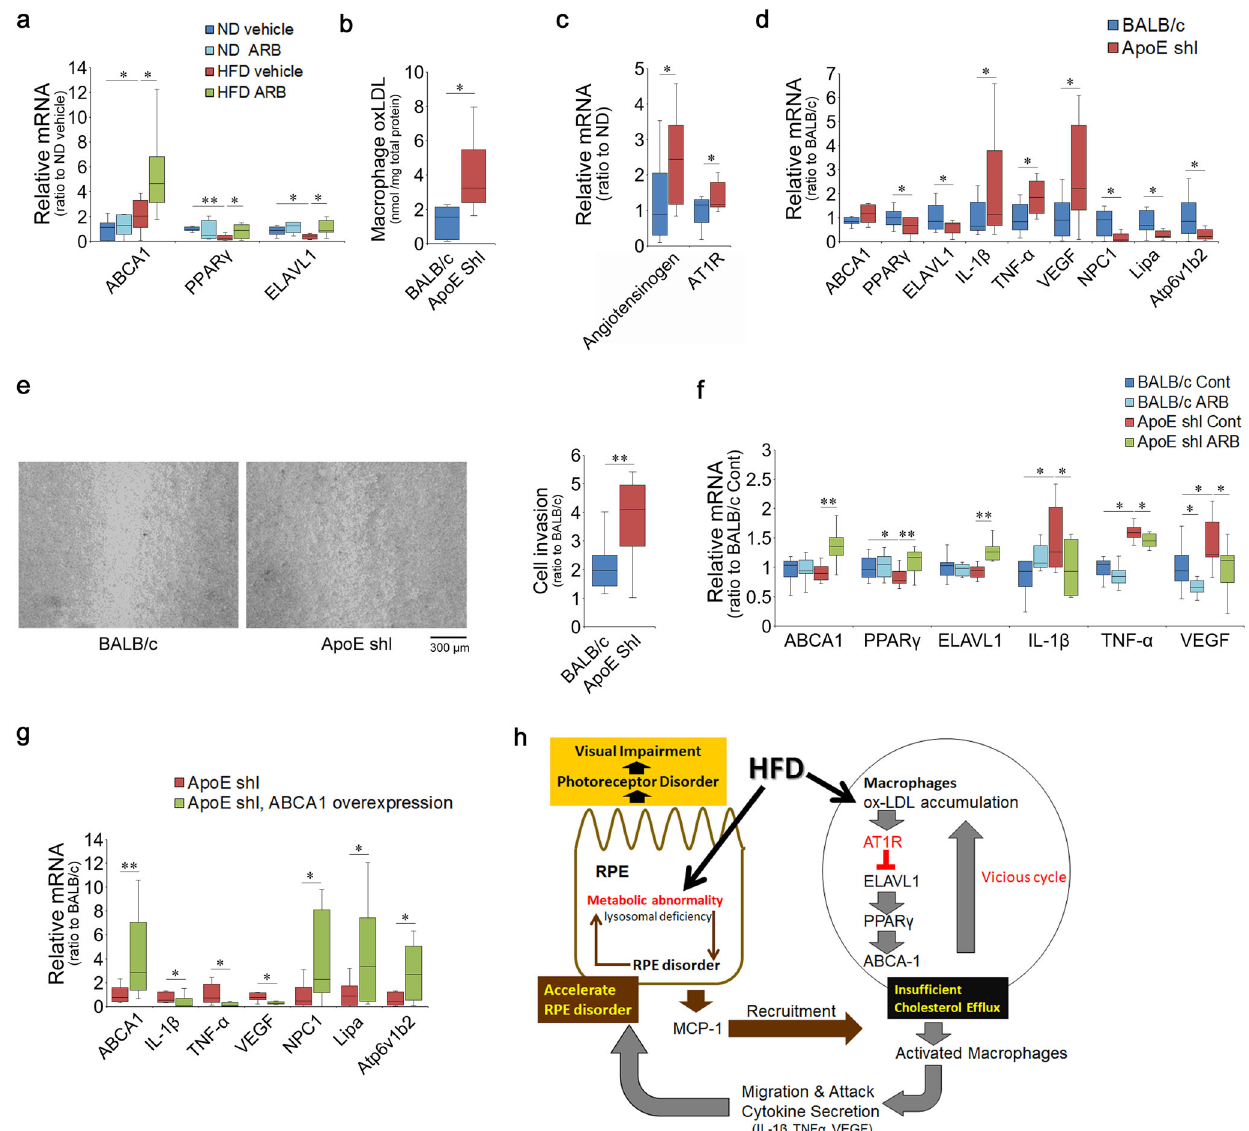
Fig. 6 Chronic HFD loading suppressed the ELAVL1/PPAR γ /ABCA1 axis through AT1R signaling in macrophages. a Peritoneal macrophages derived from ND or HFD mice at 1 month, with or without ARB treatment. ABCA1 was induced by HFD, and the level was further increased by AT1R blockade. HFD repressed PPAR γ and ELAVL1; however, these levels were recovered by AT1R blockade. b – e Peritoneal macrophages derived from ApoE -de fi cient mice were analyzed. ox-LDL levels were increased ( b ), angiotensinogen and AT1R were upregulated ( c ), and PPAR γ and ELAVL1 were downregulated, whereas the in fl ammatory cytokines, IL-1 β , TNF α , and VEGF were induced, and lysosomal markers NPC-1, Lipa, and Atp6V1b2 were repressed ( d ) in macrophages from ApoE -de fi cient mice. e Scratch assay showed that peritoneal macrophages derived from ApoE -de fi cient mice migrated more frequently and extensively. f Peritoneal macrophages derived from ApoE -de fi cient mice and cultured with ARB showed increased levels of ABCA1, PPAR γ , and ELAVL1, and decreased levels of in fl ammatory cytokines in the presence of ox-LDL. g Overexpression of ABCA1 in peritoneal macrophages derived from ApoE -de fi cient mice. ABCA1 was upregulated by the overexpression, in fl ammatory cytokines, IL-1 β , TNF α , and VEGF were downregulated, and lysosome lysosomal markers NPC-1, Lipa, and Atp6V1b2 were upregulated. h Chronic HFD may affect both the RPE to induce MCP-1 which recruits macrophages, and macrophages to impair cholesterol metabolism through AT1R signaling which results in macrophage activation. The changes may progress gradually and concurrently. The activated and recruited macrophages secrete in fl ammatory cytokines and cause further RPE disorders including lysosome de fi ciency to affect visual function. ND normal diet, HFD high-fat diet, AT1R angiotensin II type 1 receptor, ARB AT1R blocker. a Respective numbers for ND mice treated with control, ND mice treated with ARB, HFD mice treated with control, and HFD mice treated with ARB were 10, 8, 10, 8. b n = 8, c , d n = 9, and e n = 14 for each group. f Respective numbers for BALB/c mice treated with control, BALB/c mice treated with ARB, ApoE shl mice treated with control, and ApoE shl mice treated with ARB were 12, 12, 12, 11. g n = 12 for each group. The samples were all biologically independent. Data are expressed as means ± standard deviation; * P < 0.05, ** P <